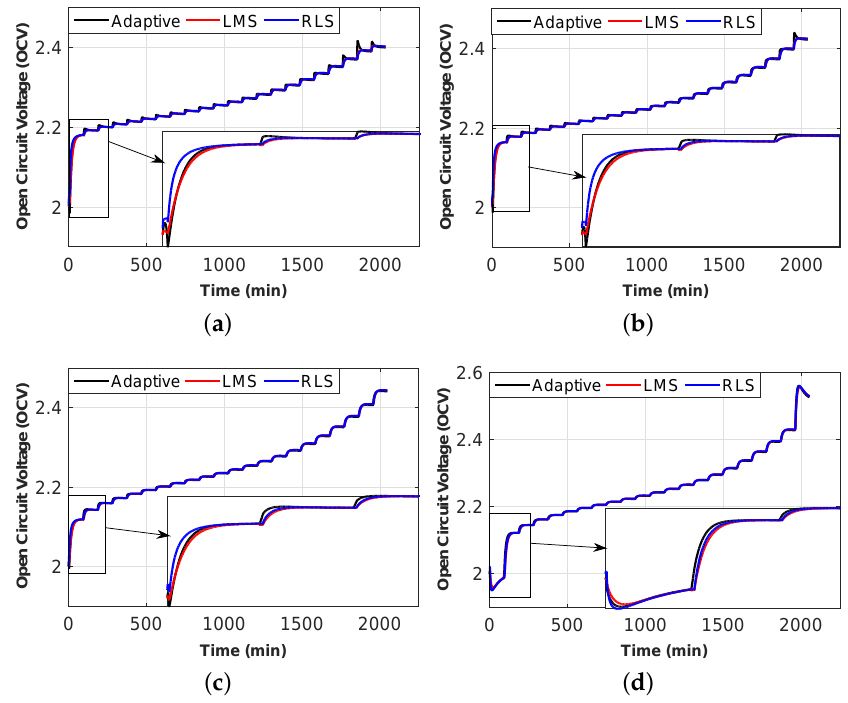
Figure 4. Open circuit voltage ( OCV ) estimation for different temperatures in charge mode. ( a ) 0 ◦ C; ( b ) 10 ◦ C; ( c ) 25 ◦ C; and ( d ) 40 ◦ C. LMS : least mean square; and RLS : recursive least